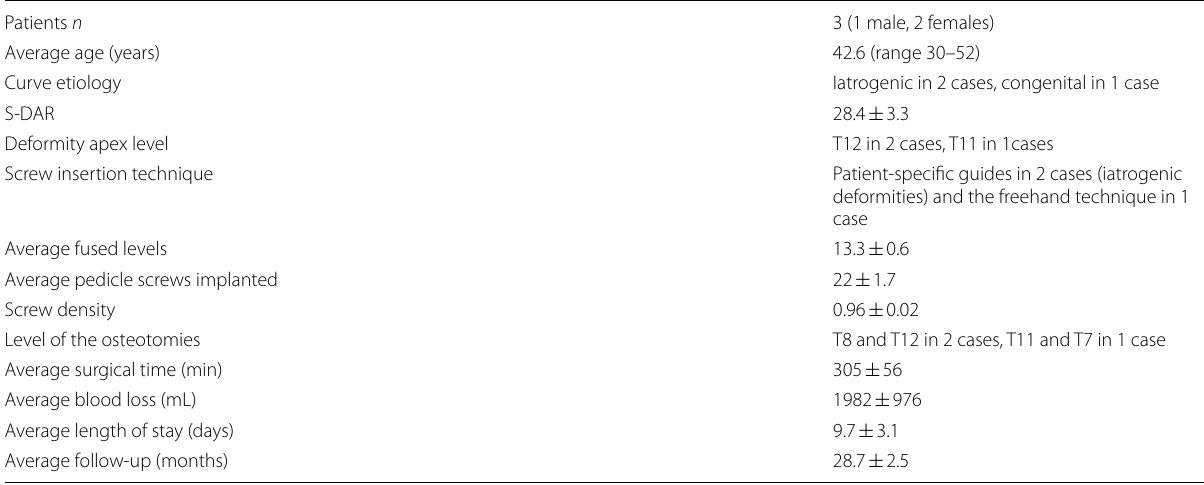
Table 1 Patient